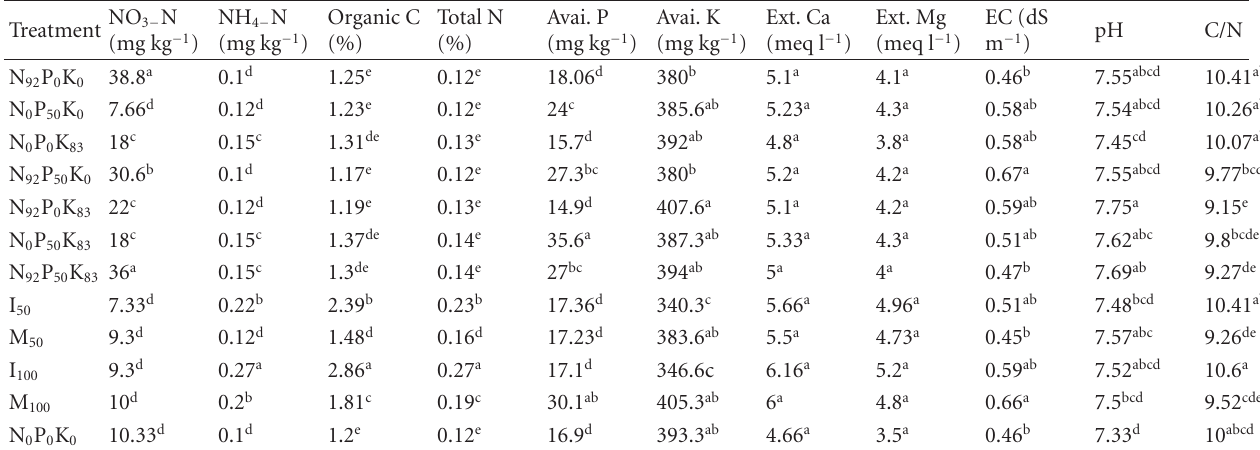
Table 5: Soil nutrient concentrations at